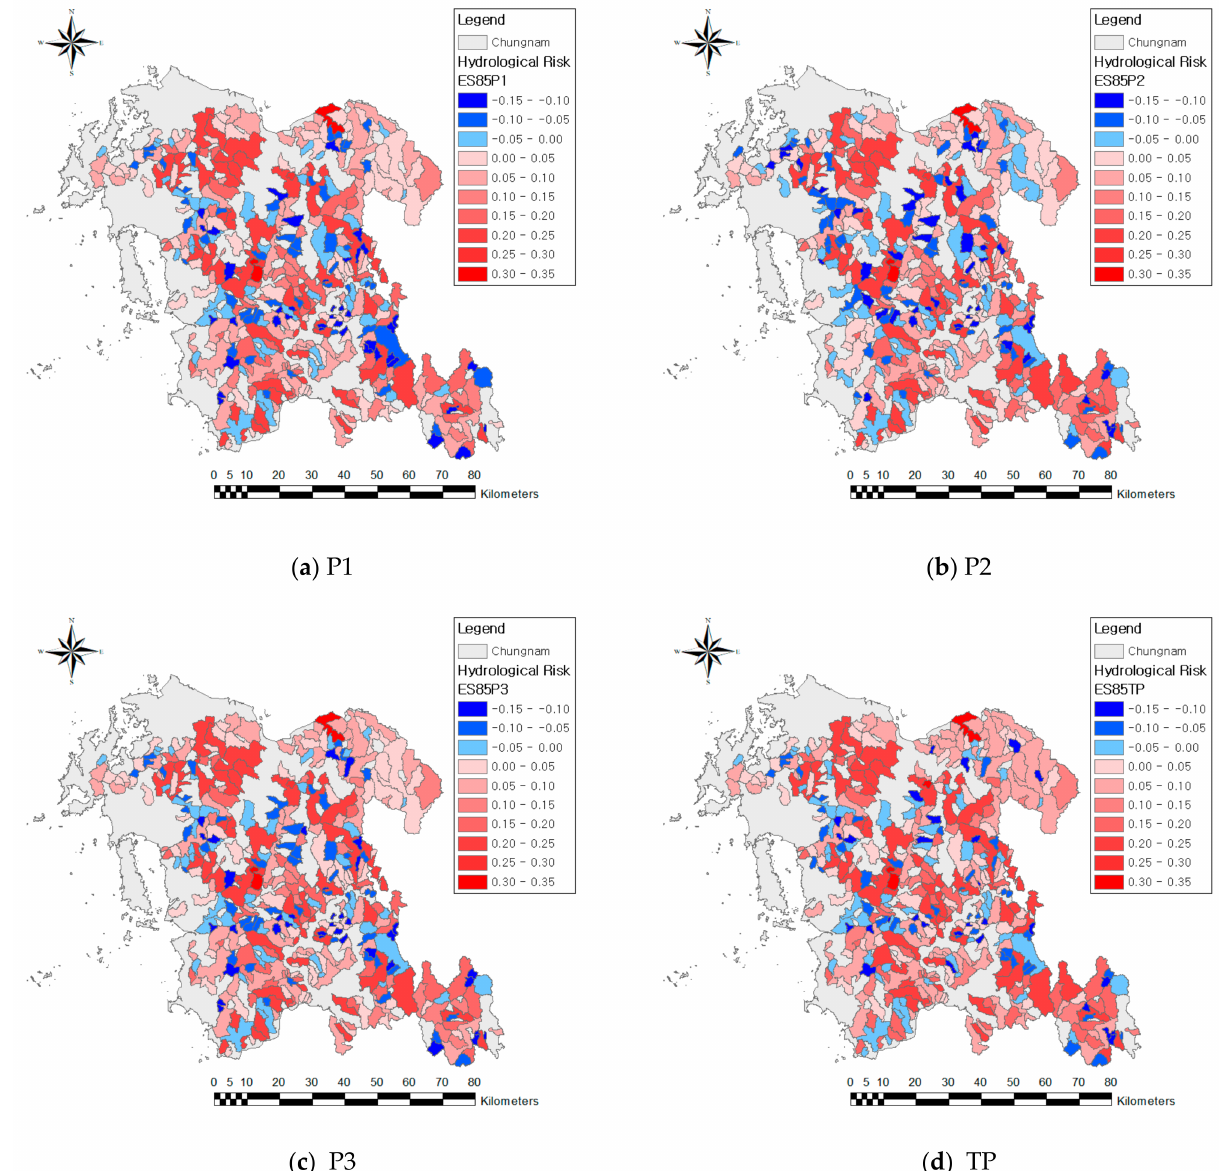
Figure 6. Hydrologic risks for the RCP 8.5